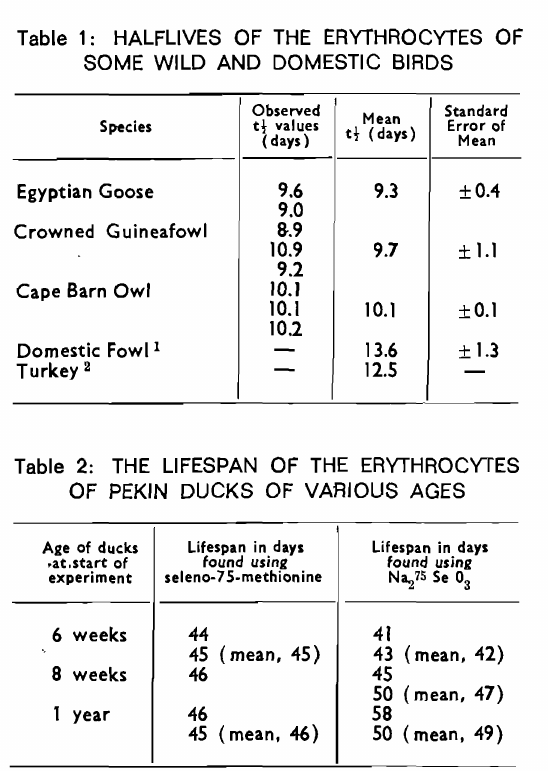
Table 2: THE LIFESPAN OF THE ERYTHROCYTES OF PEKIN DUCKS OF VARIOUS AGES Age of ducks Lifespan in days Lifespan in days .at.start of found using found using experiment